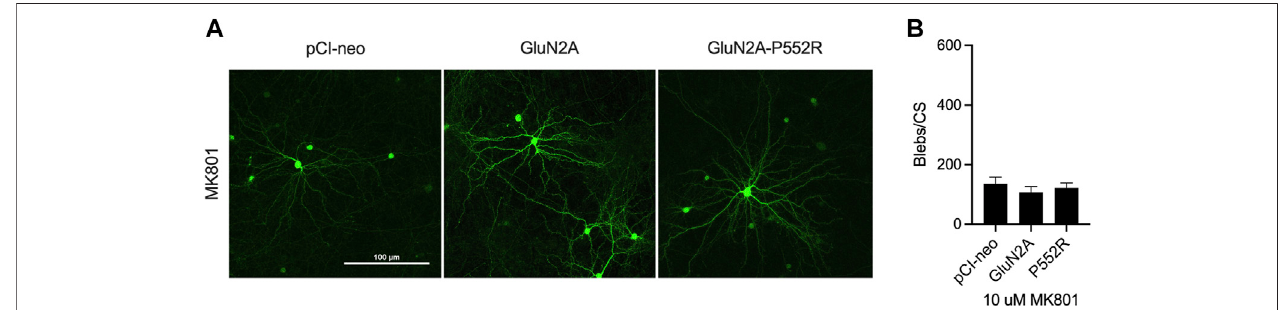
FIGURE3| Dendriticblebbingisattenuated bytreatment withthechannelblockerMK801. Representativeimagesofratcorticalneuronstransfected withpCI-neo empty vector, GluN2A-WT, and GluN2A-P552R and co-treated with 10 µM MK801 (A) . GluN2A-P552R expressing neurons treated with 10 µM MK801 show a signi fi cant reduction in blebbing (B) (one-way ANOVA, p > 0.05, n (cid:2) 9). Data are ± SEM from three independent experiments with three coverslips analyzed per experiment.